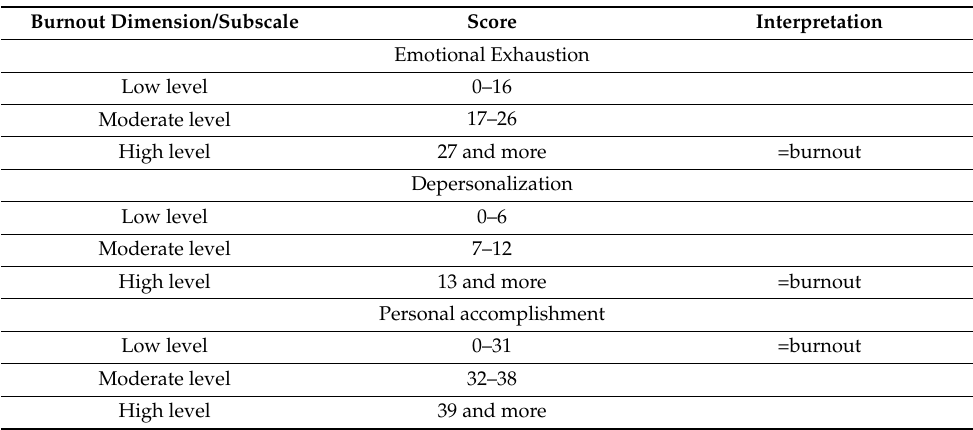
Table 1. Score assessment of burnout in three dimensions